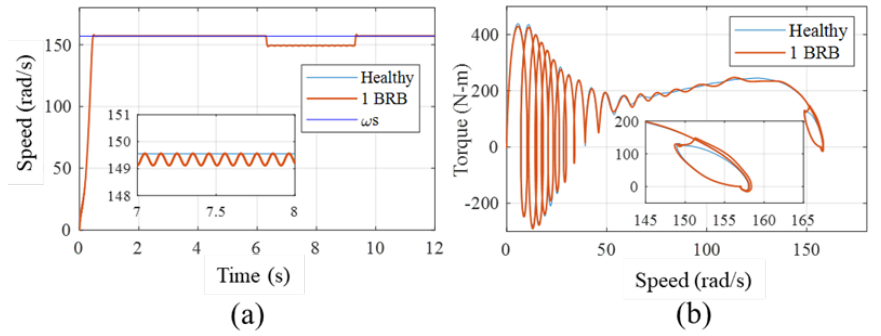
Figure 3. ( a ) The speed dynamic response under healthy and faulty cases. ( b ) The speed–torque dynamic response under the healthy and broken bar cases with shifting of the operating point upon the application of a load in the zoomed window.